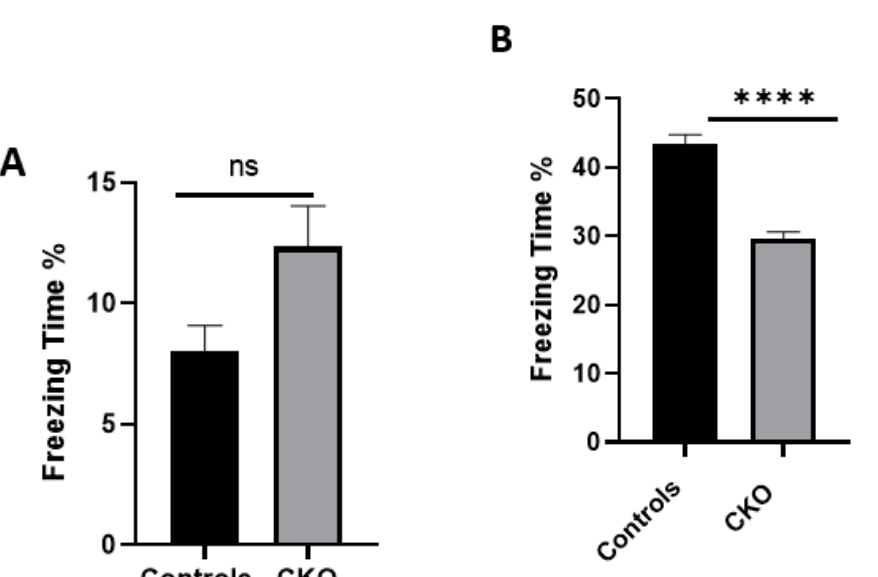
Figure 8. Contextual fear conditioning deficits in the CKO mice. ( A ) For the contextual fear condi- tioning test, mice were trained and analyzed for freeze response. The scores of the freezing time (%) for the control mice and the CKO on day one show little difference; ( B ) CKO animals had a lower freezing time % score on day two compared to the controls. Freezing response is the percentage of time spent freezing from the total time duration. Data represent the mean ± SEM. n = 16. Statistical